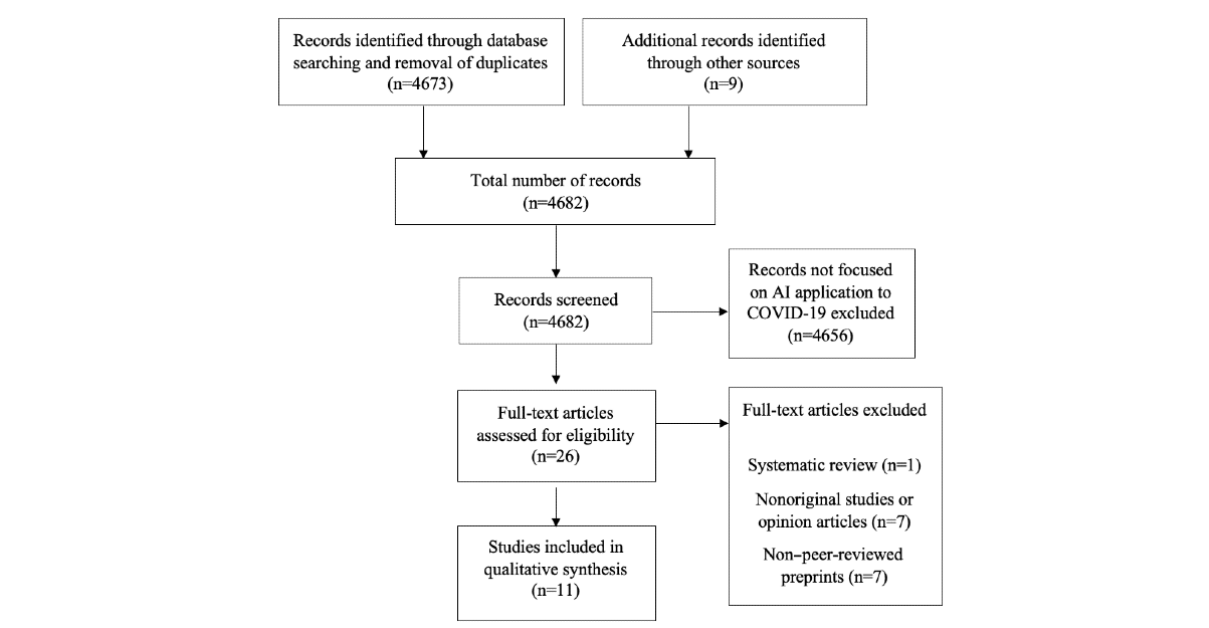
Figure 1. Study flow